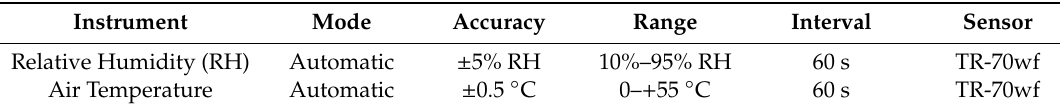
Table 3. Introduction of the measured instruments.